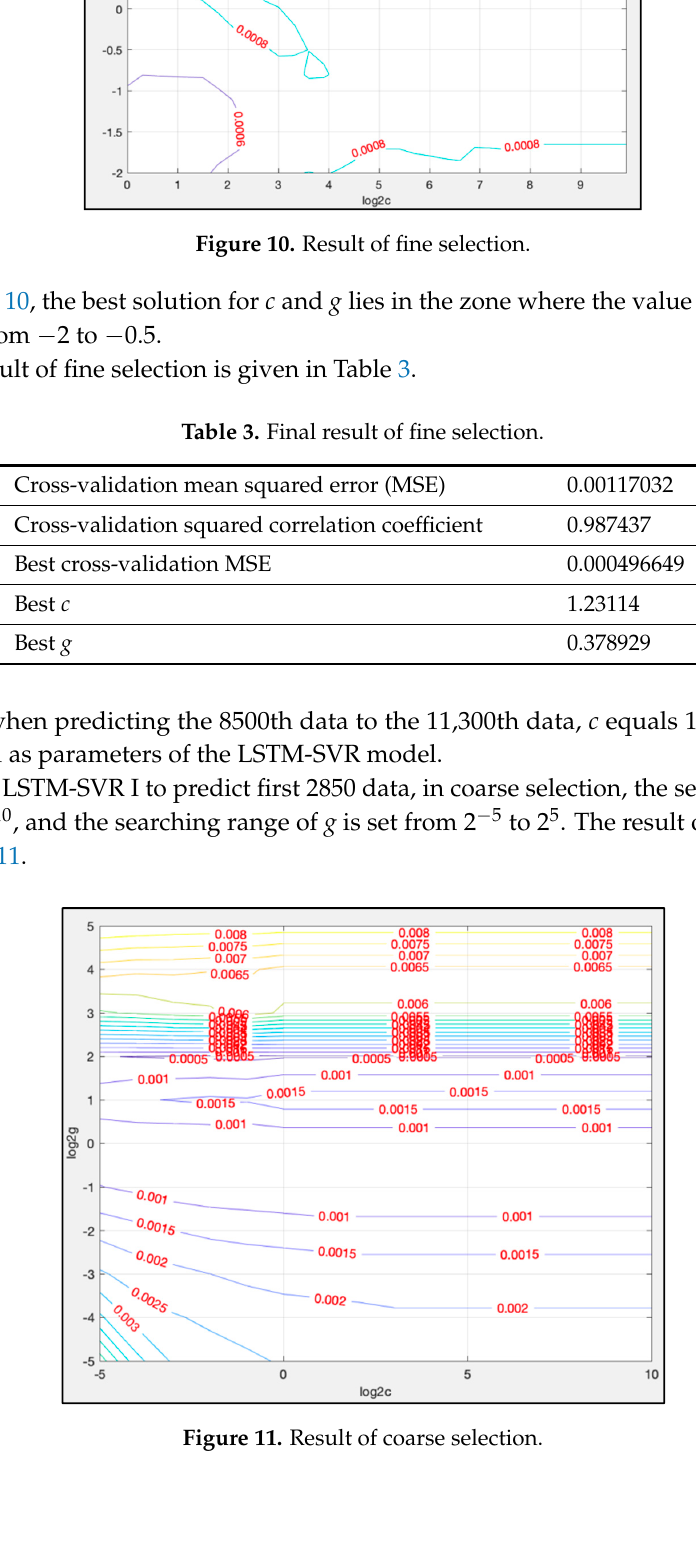
Figure 12. Results of fine selection. The results of the final selection are given in Table 4: